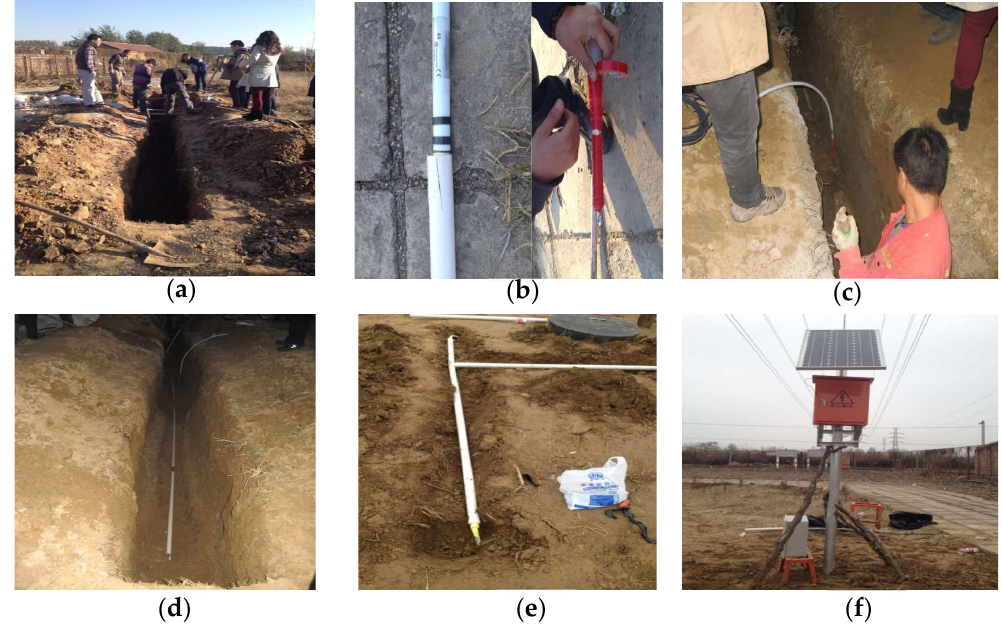
Figure 4. Charts of the SAA installation process. ( a ) Excavated foundation pit; ( b ) Schematic diagram of fixed protection for SAA sensors; ( c ) Vertically embedded SAA sensor in the ground fissure; ( d ) Horizontally embedded SAA sensor in the ground fissure; ( e ) Buried polyvinyl chloride (PVC) pipes for data connection protection; ( f ) Solar energy storage devices and data acquisition devices.